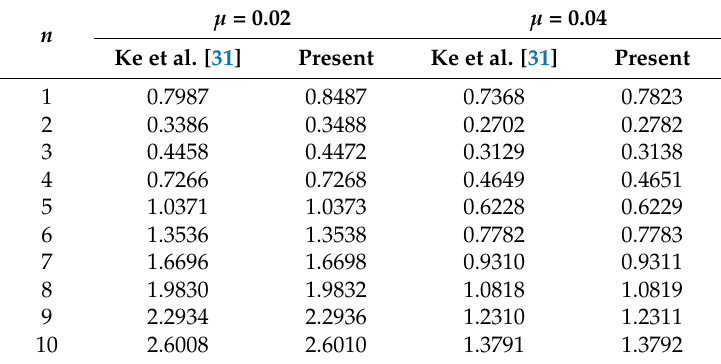
Table 4. Comparison of natural frequency ω (GHz) of a C–C homogeneous piezoelectric nanoshell ( µ = e 0 a / L